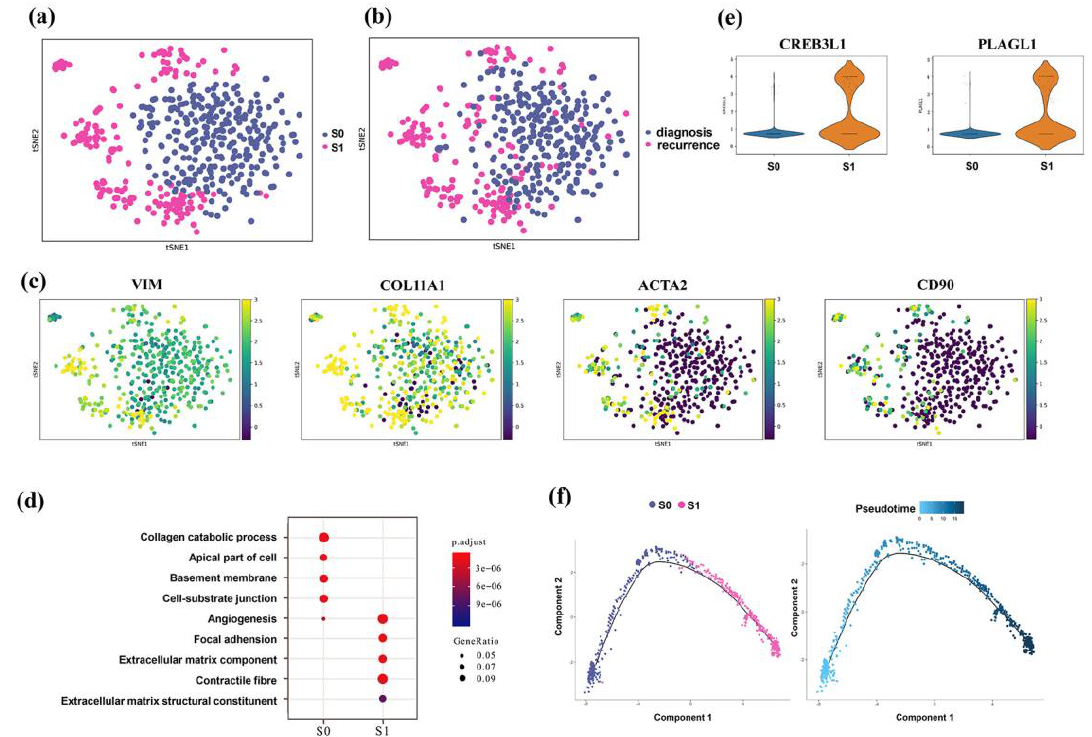
Figure 5. Activation of the cancer-associated fibroblast subset in EOC progression. ( a , b ) T-SNE view of fibroblasts, colored by cell types ( a ) and sample groups ( b ). ( c ) General stromal markers for fibroblasts and representative markers for ACTA2-positive fibroblasts. ( d ) Functional analysis of differentially expressed genes among the two subtypes of fibroblasts. ( e ) Vlnplots show the expression of genes that regulate ECM formation and components across the two fibroblast subtypes. ( f ) Pseudotime trajectory of the two subgroups of fibroblasts inferred by Monocle 2.